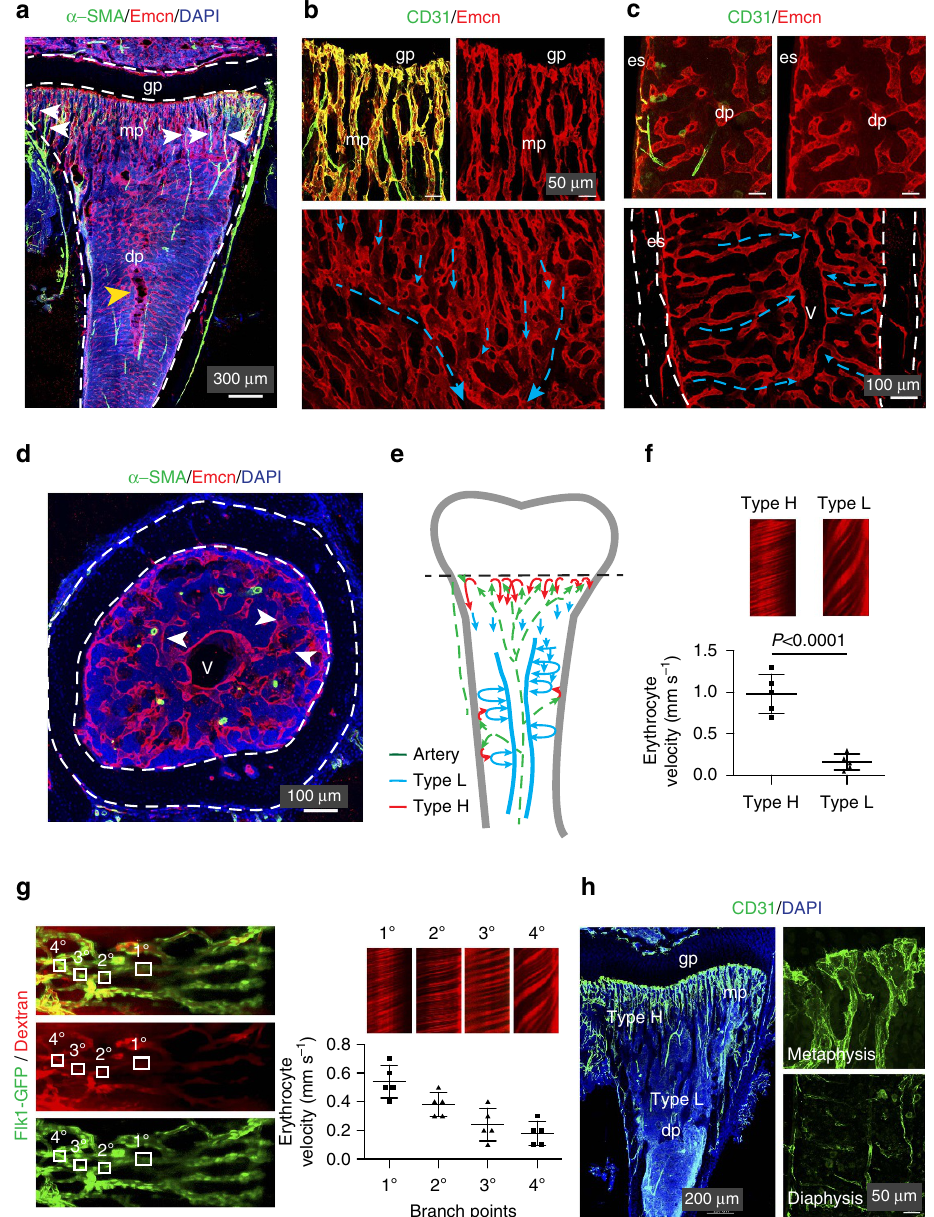
Figure 1 | Blood flow dynamics in long bone. ( a ) Tile scan image of tibial vasculature immunostained for Emcn (red) and a -smooth muscle actin (green). Arteries covered by a -SMA þ cells connect (arrows) to metaphyseal (mp) type H vessels near growth plate (dashed lines, gp). Sinusoidal type L vessels connect to central large vein (yellow arrowhead). ( b , c ) Confocal images of 4-week-old metaphysis near growth plate (gp) ( b , top panels) or diaphysis (dp) ( c , top). CD31 þ (green) Emcn- (red) arteries terminate in CD31 þ Emcn þ type H vessels in the metaphysis (mp) and endosteum (es) but not in type L vessels in diaphysis (dp). Blue arrows in Emcn-stained (red) overview images (bottom panels) illustrate blood flow direction from metaphyseal vessel columns ( b ) and endosteum ( c ) into the adjacent sinusoidal network and veins. ( d ) Maximum intensity projection of transversal sections of 4-week-old tibia immunostained for a -SMA (green) and Emcn (red). Sinusoidal type L vessels (arrowheads) connect to a large central vein (v). Multiple smooth muscle-covered CD31 þ Emcn-arteries cross the diaphysis. Dashed lines mark compact bone. ( e ) Diagram of arterial (green arrows), type H (red arrows) and sinusoidal/venous flow (blue arrows) in murine long bone. ( f ) Graph showing blood velocities calculated from line scanning of type H and type L vessels after Dextran (2,000,000Da) injection. Data represent mean ± s.d. ( n ¼ 5 biological replicates). P values, two-tailed unpaired t test. ( g ) Overview image and representative line scans showing blood velocities in 2-week-old long bone. Note decreasing velocity of erythrocytes at each branch point (represented as 1 (cid:2) , 2 (cid:2) , 3 (cid:2) , 4 (cid:2) ) at the interface between columnar type H (right) and diaphyseal type L vessels (left). Data represent mean ± s.d. ( n ¼ 5 biological replicates). ( h ) Confocal images of CD31 (green) expression in the metaphysis and diaphysis of 4-week-old tibia. Note differences in CD31 levels. Scale bars are as indicated in the respective images. DAPI (blue) is used for counterstaining of